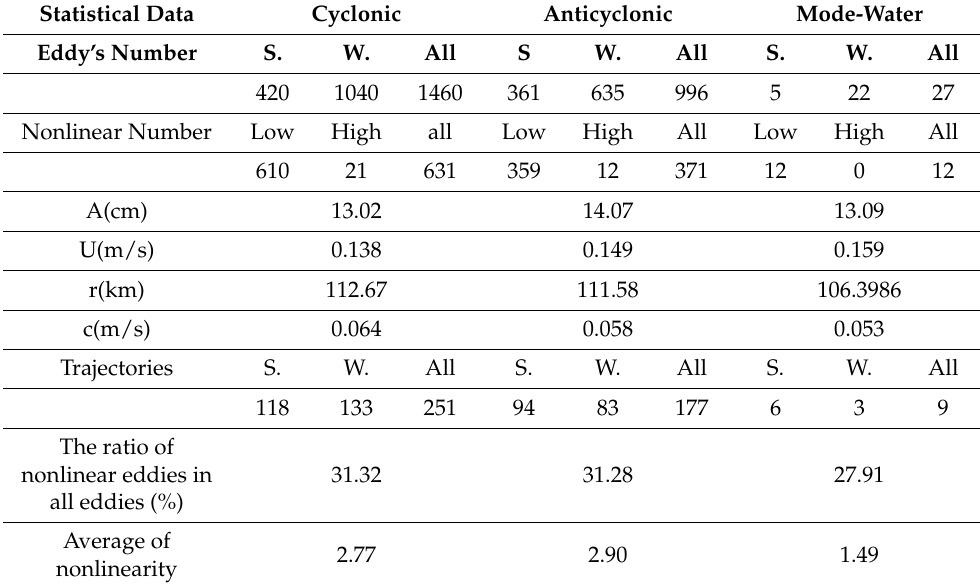
Table 1. Statistical data of various eddies in the NSCS (S. means summer, W. means winter.). Statistical Data